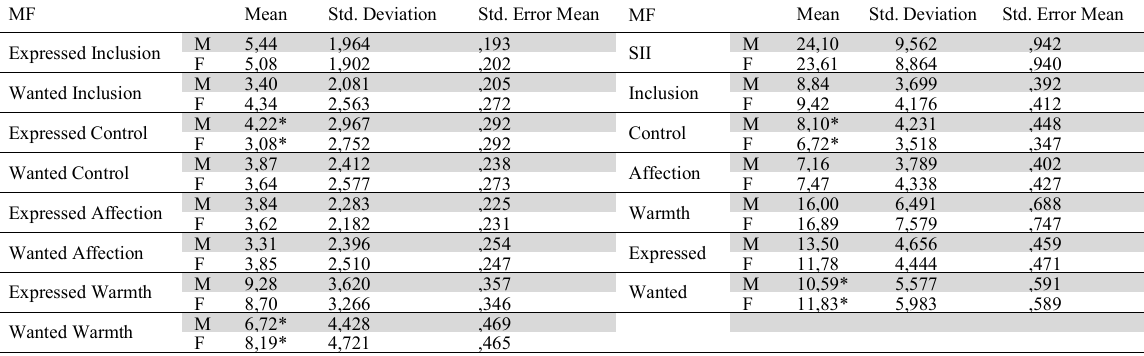
The analysis of differences between male and female scores MF Mean Std. Deviation Std. Error Mean Std. Deviation Std. Error Mean